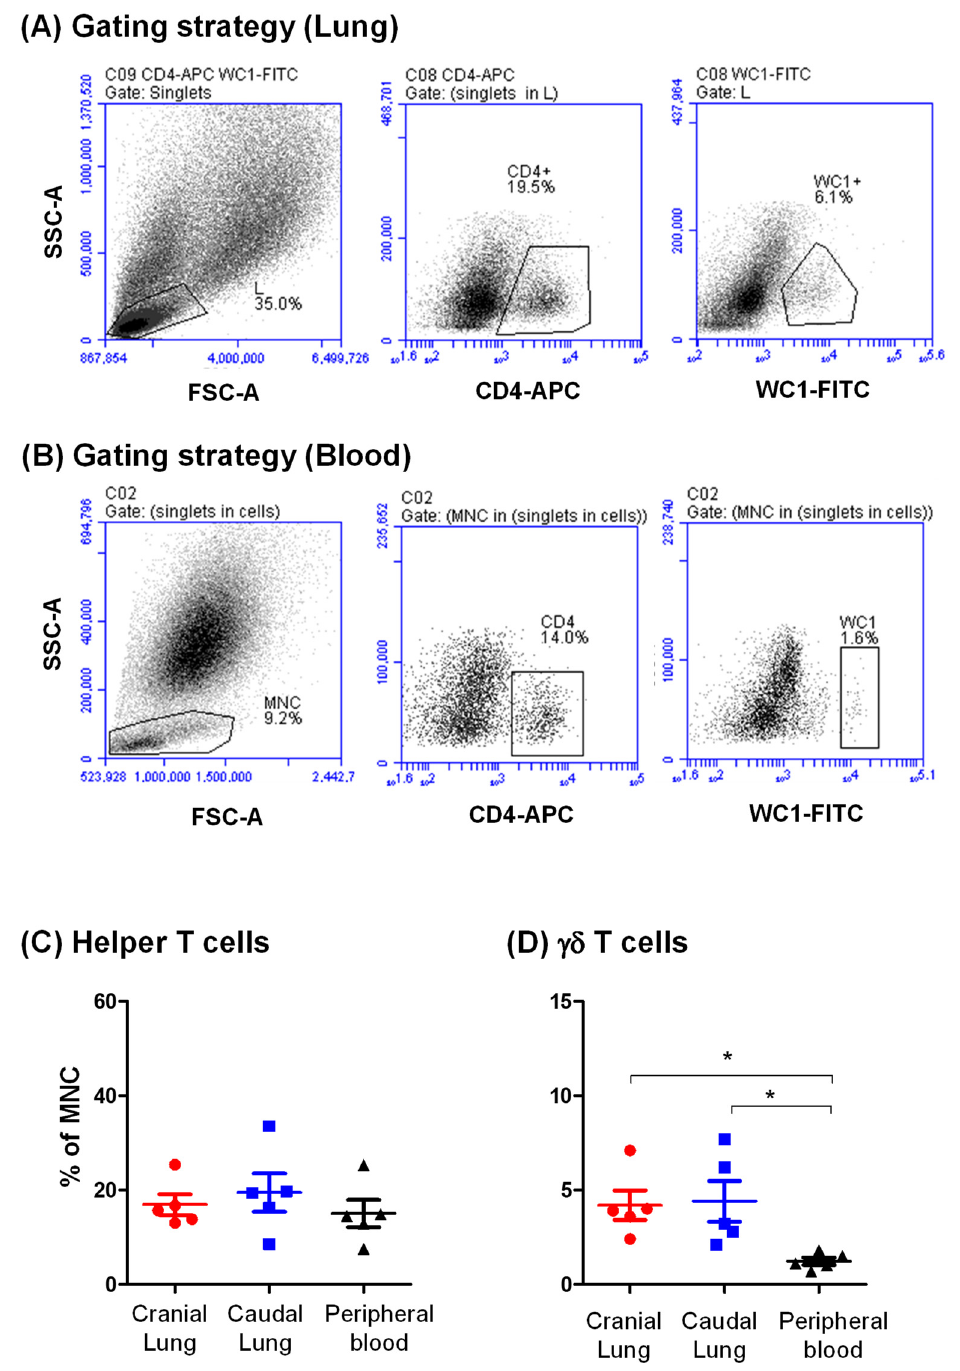
Figure 4. Flow cytometric analysis of selected lymphocyte subsets in the lung tissue and peripheral blood of dromedary camels. Lung cells or blood leukocytes were labeled with monoclonal antibodies to CD4 and WC1, and labeled cells were analyzed by flow cytometry. After setting a gate on lung lymphocytes ( A ) and blood mononuclear cells ( B ), the CD4-positive T helper cells and WC1-positive γδ T cells were identified based on their higher expression of the marker molecules. Data for cranial and caudal lung tissue and blood leukocytes were calculated and presented graphically for helper T cells ( C ) and γδ T cells ( D ). * indicates a significant difference between the two groups ( p < 0.05).